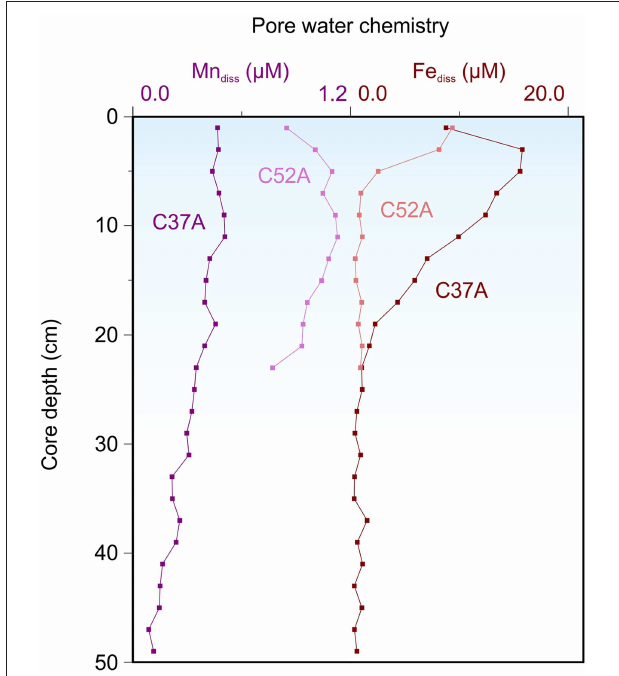
FIGURE 3 | Pore water chemical profiles in cores PALEOMAR-I C37A from Alfonso Basin and PALEOMAR-I C52A from La Paz Basin (Data: Choumiline et al.,